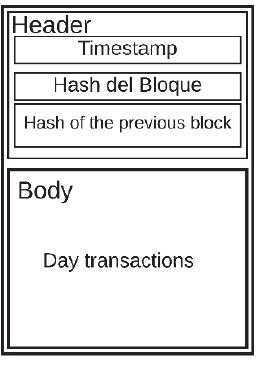
Figure 8. Blockchain design.